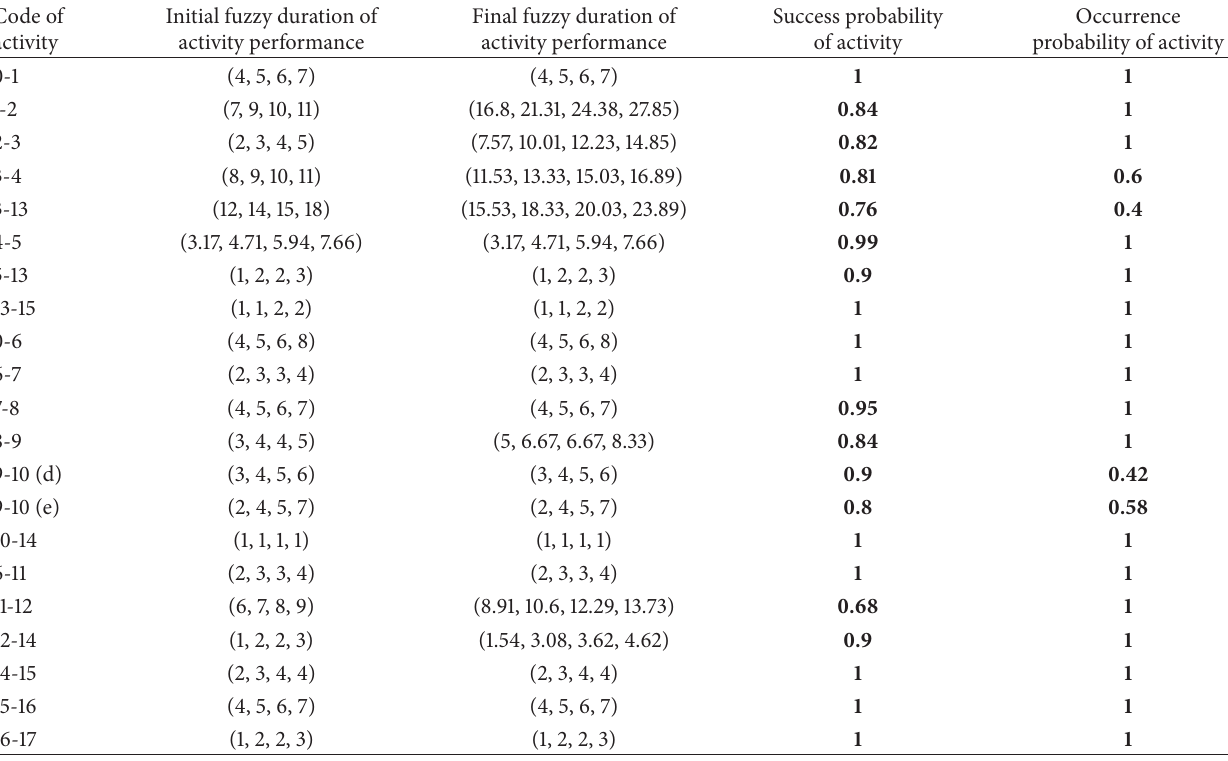
Table 5: Input parameters of activity network without any loops.